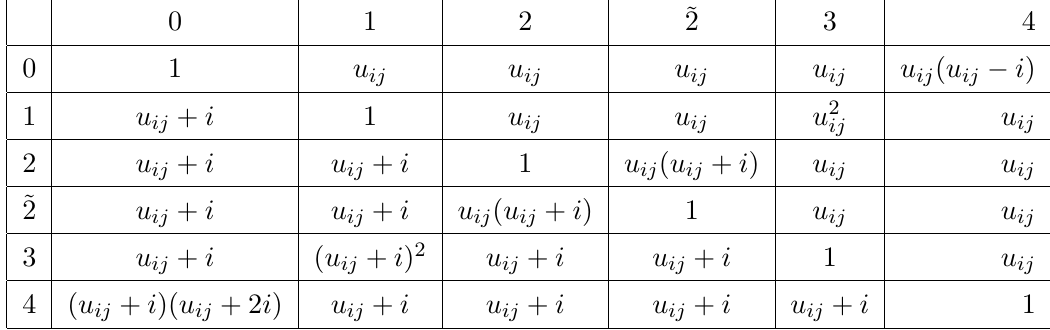
Table 2 . This table gives P ( u i , Y i | u j , Y j ) for all diagrams i.e. Y i , Y j ∈ { 0 , 1 , 2 , ˜2 , 3 , 4 } . For example P ( u i , 2 | u j , 1) = u ij + i .